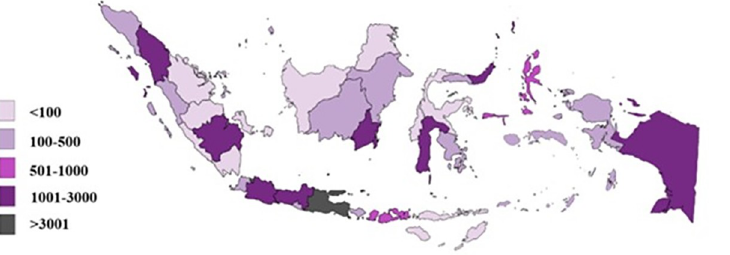
Fig 4. Distribution map of COVID-19 cases in Indonesia, August 2 nd 2020.